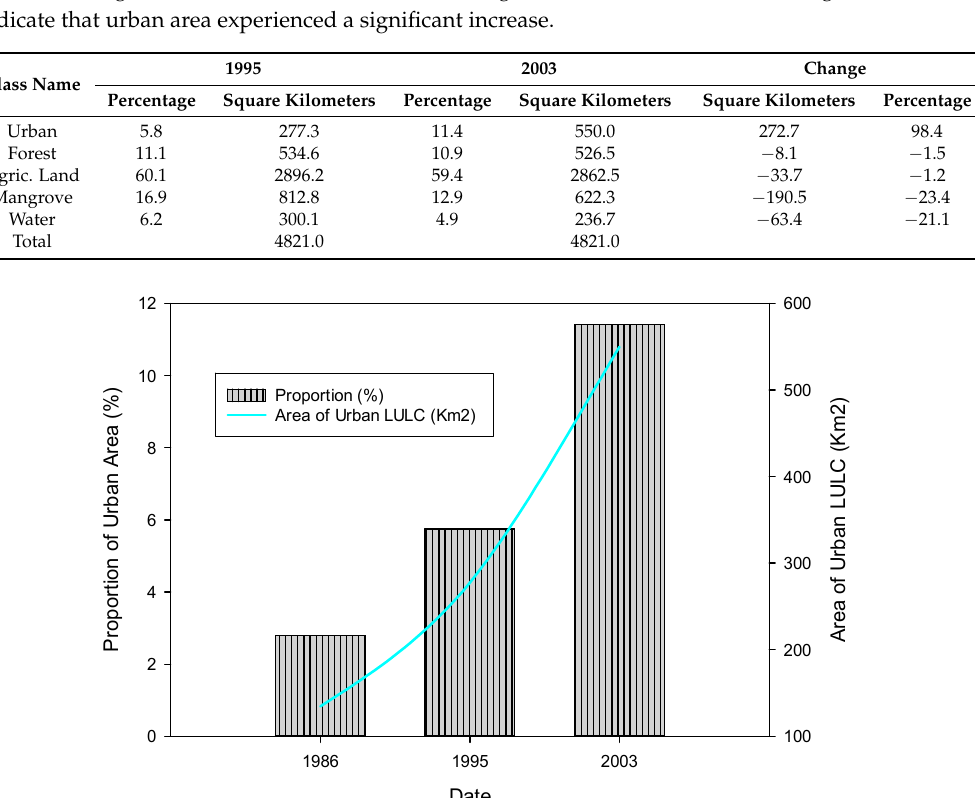
Table 3. Changes in urban area and other LULC categories between 1986–1995. Changes in this table indicate that urban area experienced a significant increase.